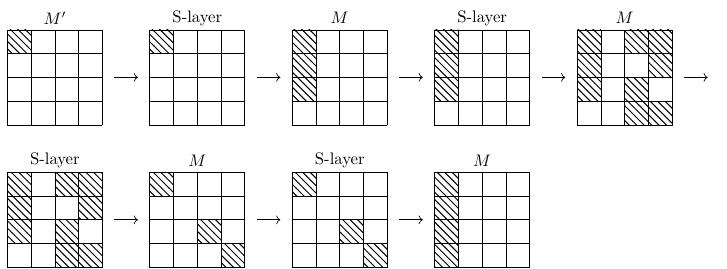
Figure 11: Linear trail over Prince starting with one active cell in the first diffusion layer including the key schedule.